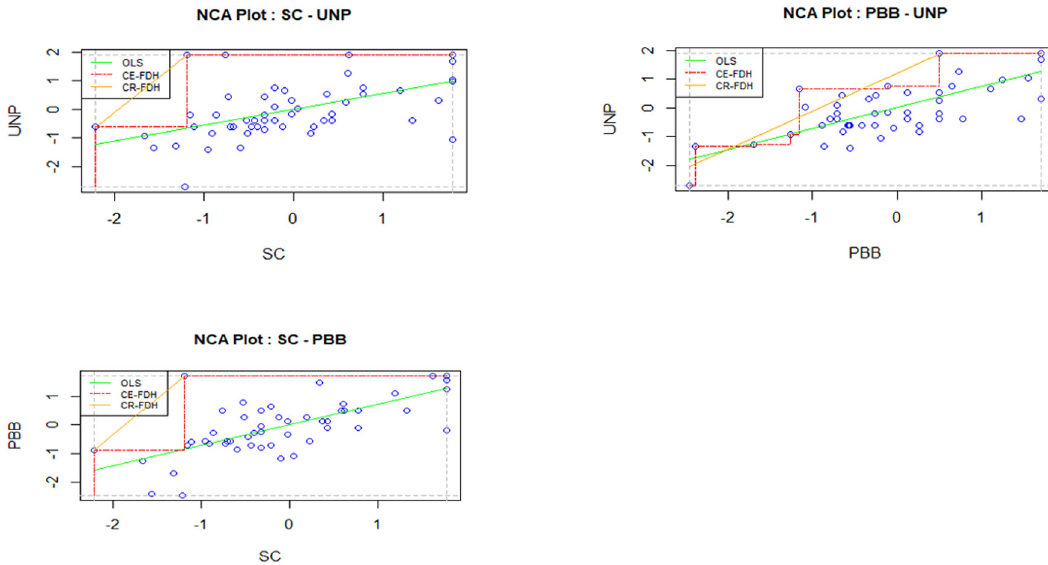
Fig. 4 NCA scatter plots. A description of the scatter plots for all relevant